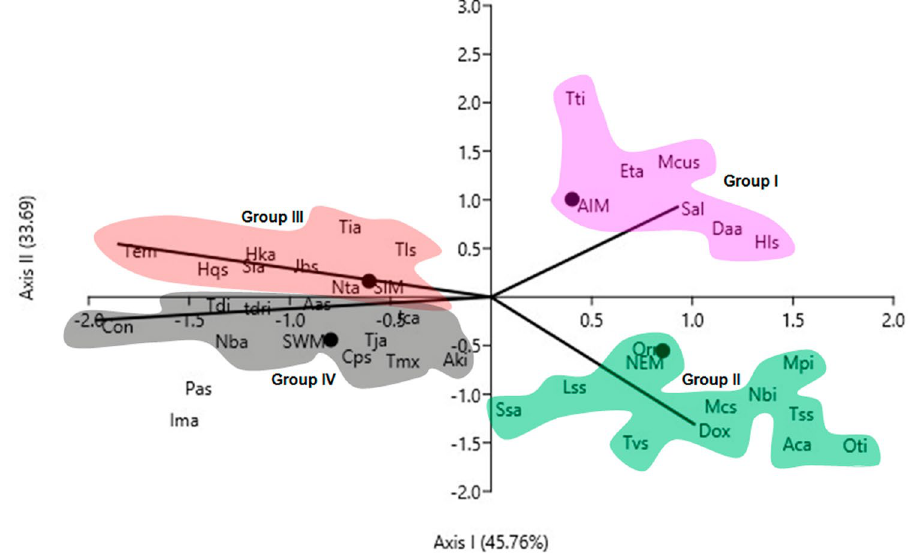
Fig. 6 Bi-plot established to understand influence of environmental parameters on the distribution of fish species based on seasonal changes. To increase readability it is further divided in four respective